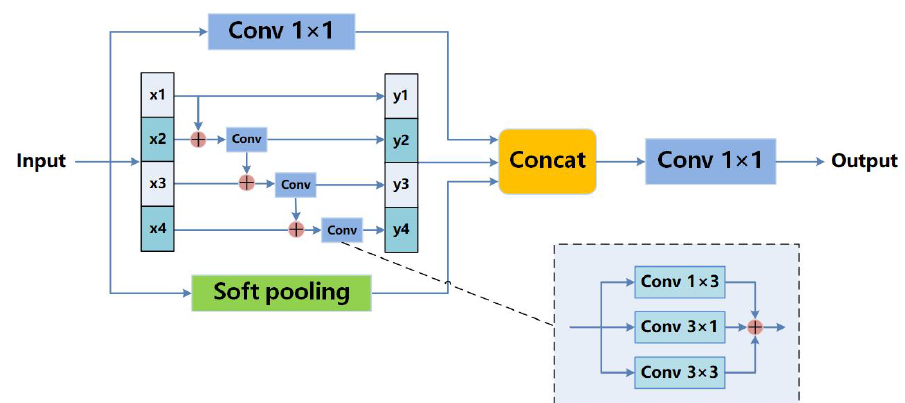
Figure 5. Multi-scale capture block.